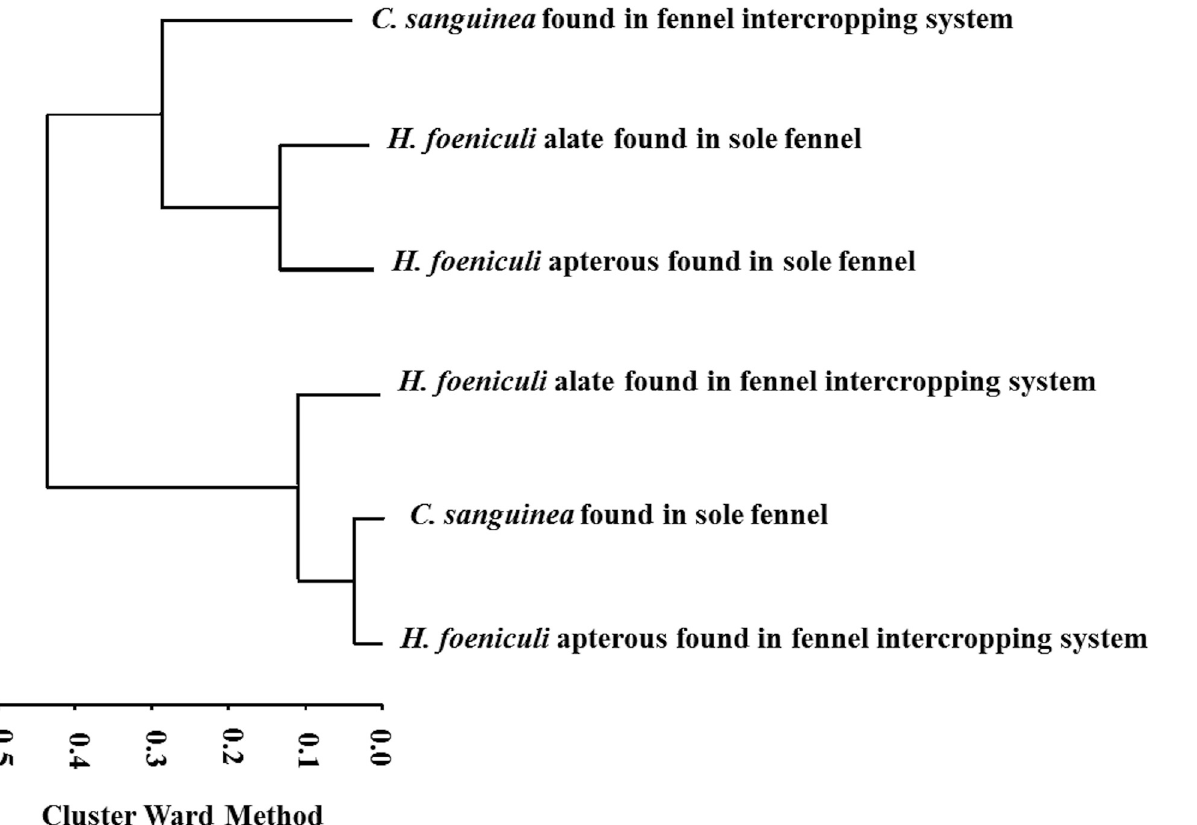
Fig 1. Co-occurrence of H . foeniculi and C . sanguinea in sole fennel and intercropped